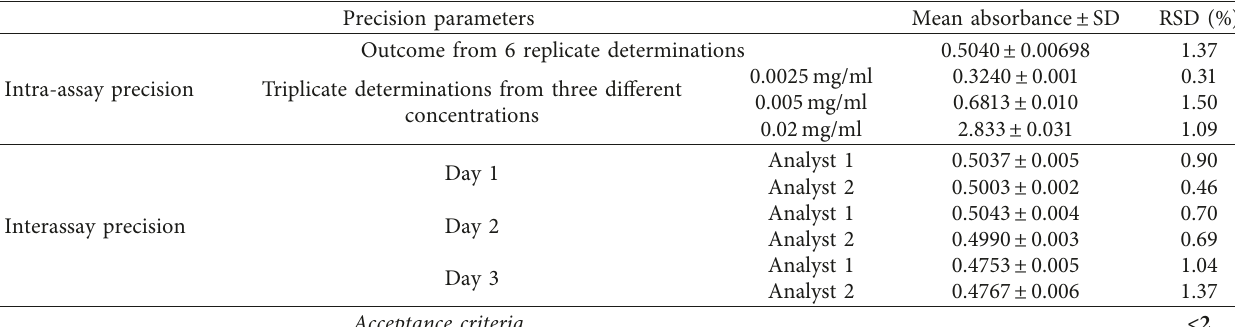
Table 3: Results showing precision of results from the developed method.